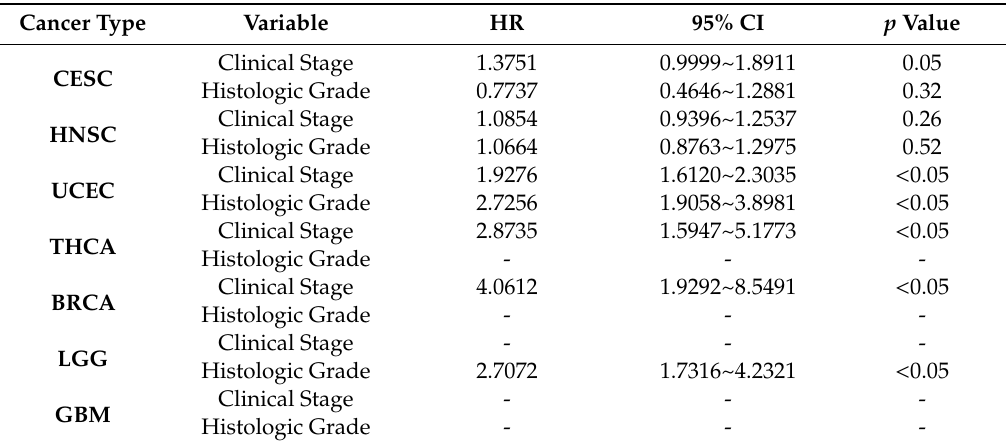
Table 1. Univariate Cox regression